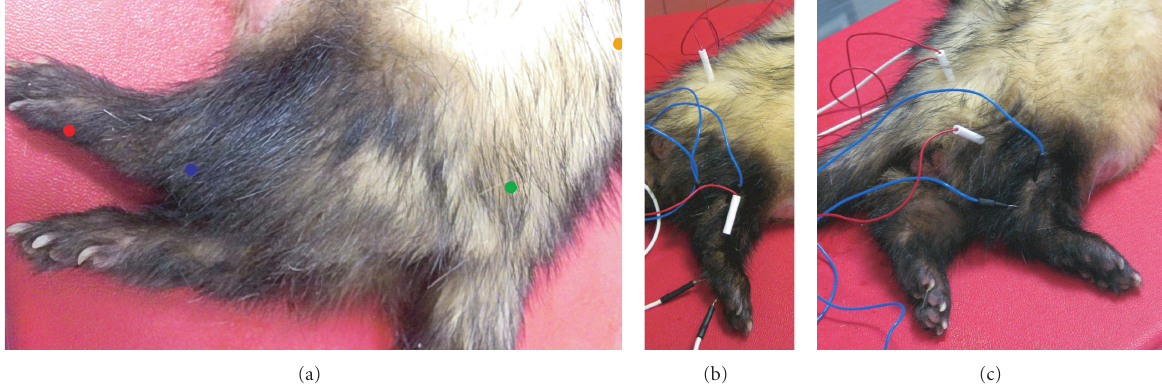
Figure 1: (a) Schematic representation of the points of stimulation and recording of the electrodiagnostic tests. Red dot: plantar interosseous muscles. Blue dot: stimulation of the sciatic-tibial nerve at the tarsus. Green dot: stimulation of the sciatic-tibial nerve at the femoral neck. Orange dot: recording of the CDP at the intervertebral space L4-L5. (b) Image of MNCS of the right sciatic-tibial nerve showing the points of insertion of the needle electrodes used for proximal stimulation (red and white wires) distal stimulation (blue and black wires), and recording (white and black wires). The single red and white wire whose needle is inserted between distal stimulation and recording is the ground electrode. (c) Image of the CDP test of the right tibial nerve showing the points of insertion of the needle electrodes used for stimulation (blue and black wires) and recording (white and black wires). The red and white wires whose needles are inserted between stimulation and recording are the ground electrode and the electrodes used for the proximal stimulation during MNCS.